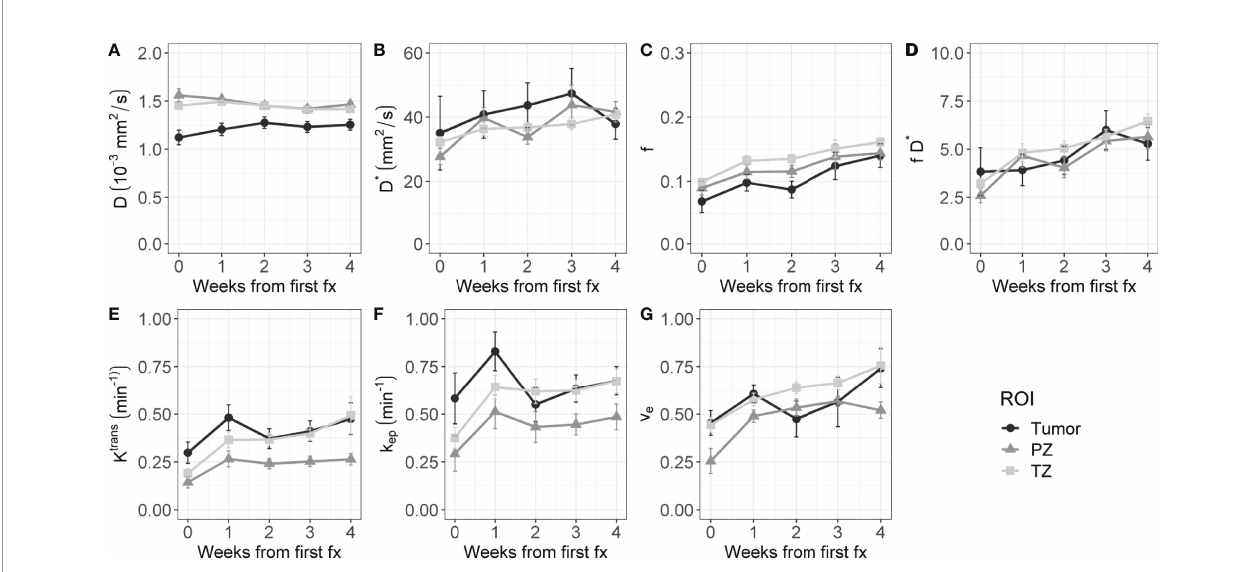
FIGURE 2 | Evolution of intravoxel incoherent motion (IVIM, A – D ) and dynamic contrast-enhanced (DCE, E – G ) parameters during radiation treatment. The average value of all patients is shown for the tumor, PZ, and TZ. Error bars indicate the standard error of the mean (SEM).